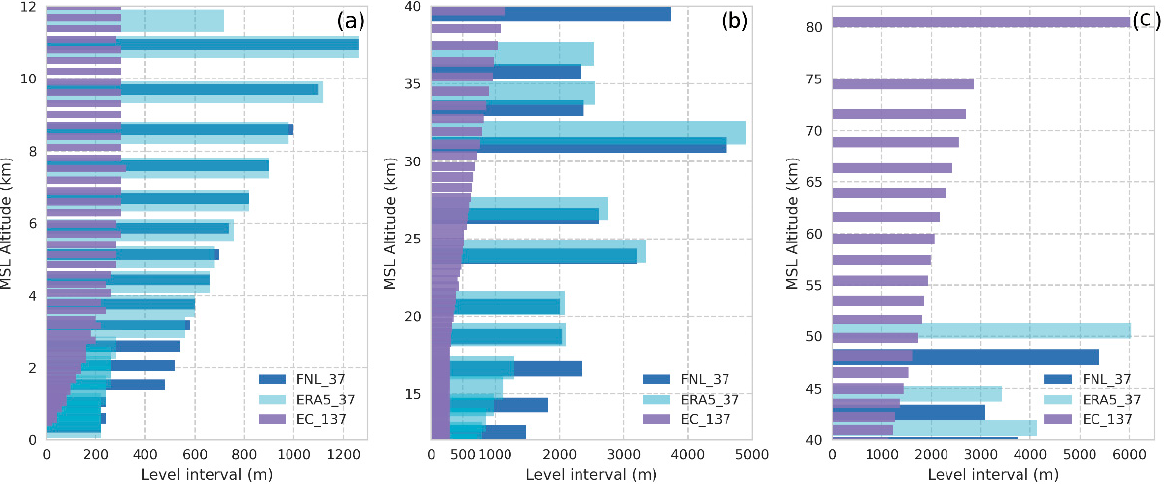
Figure A3. Level interval of FNL, ERA5, and EC4Dvar. Interval decreases with increasing height. ( a ) 0–12 km, ( b ) 12–40 km, ( c ) 40–80km.